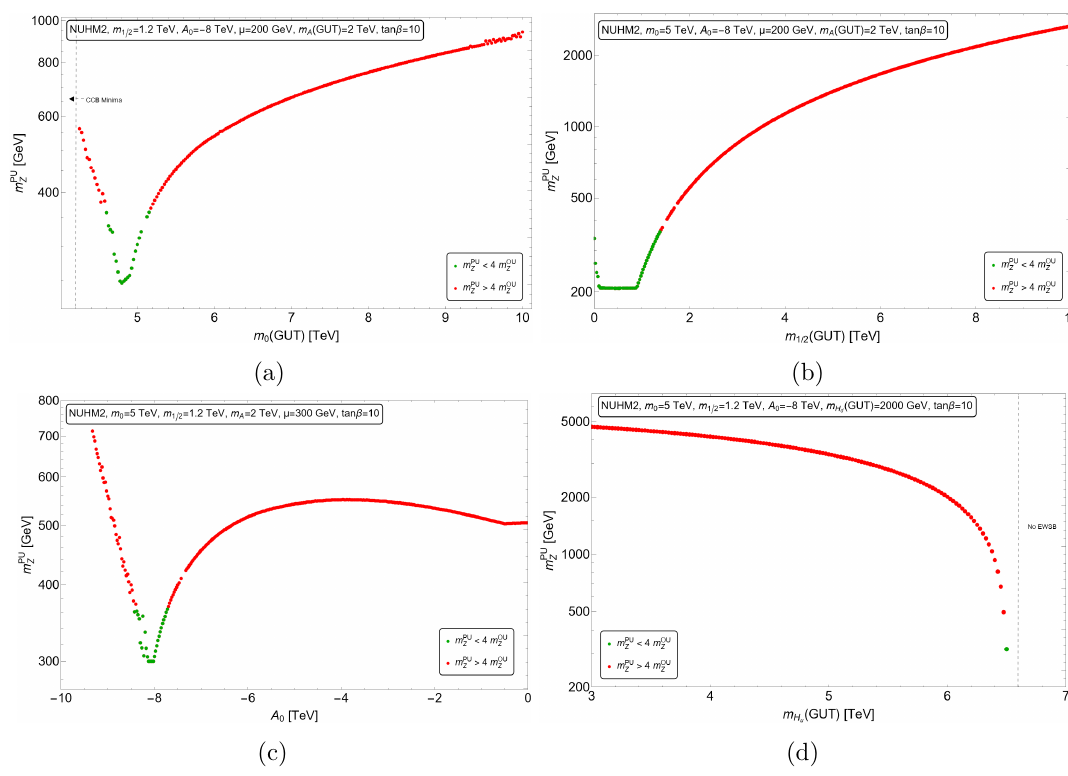
Figure 4. The value of m PU vs. various NUHM2 model parameters to illustrate the substantial weak hypercube of parameter values which lead to m PU within the ABDS window. The green points Z denote vacua with appropriate EWSB and with m PU < 4 m OU so that the atomic principle is weak weak satisfied. Red points have m PU > 4 m OU . Parameter values include (a) m 0 (1 , 2 , 3) , (b) m weak weak (c) A 0 and (d) m H u